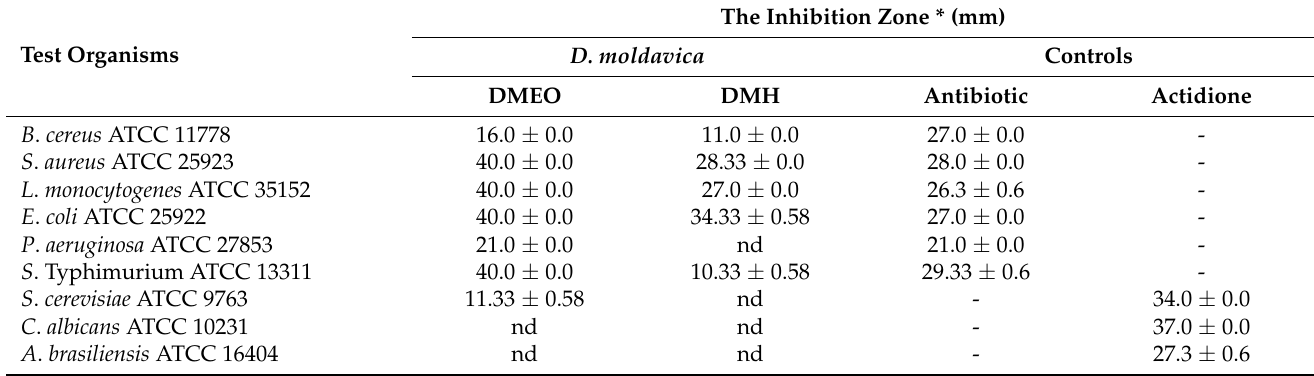
Table 3. Assessment of the antimicrobial